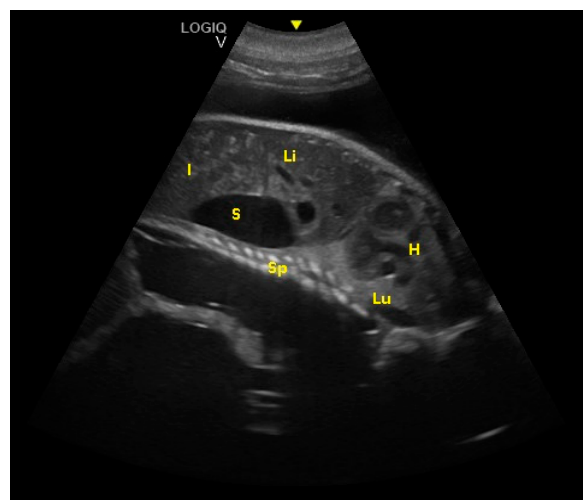
Figure 7. Fetal spinal cord (Sp), stomach (S), liver (Li), intestine (I), lungs (Lu), and heart (H) were visualized at 194 ± 5 days of gestation.